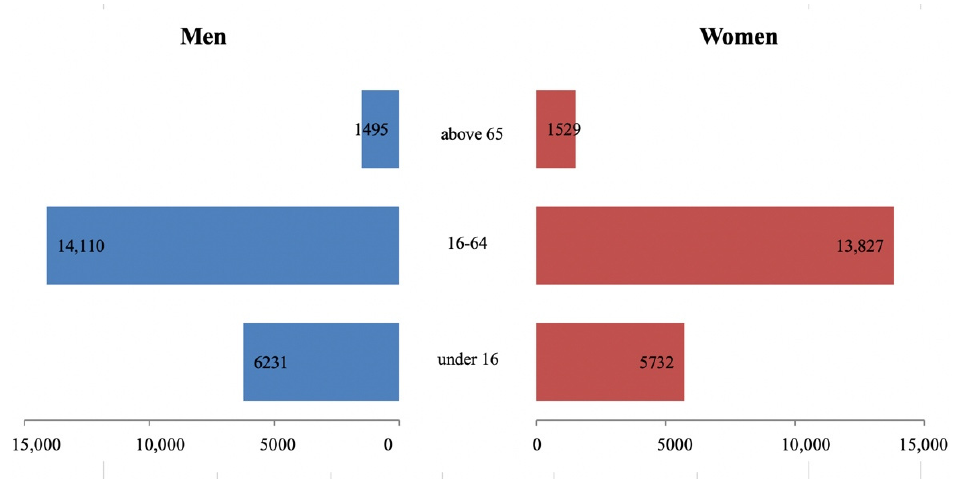
Figure 1. Catalans living in Germany according to age (INE 2020).